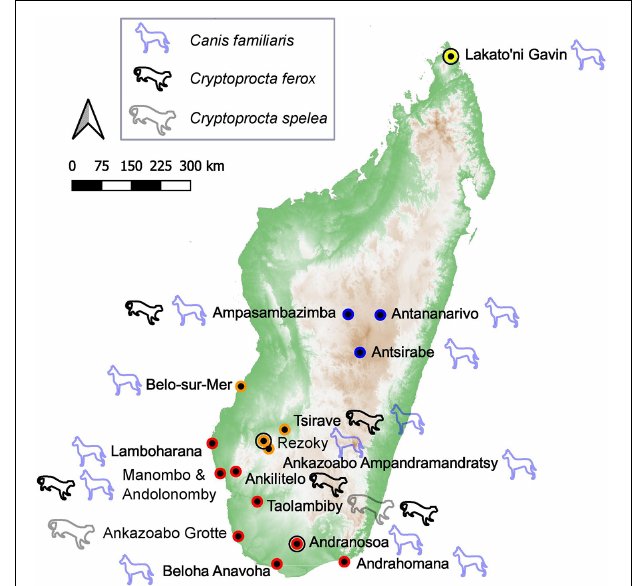
FIGURE 3 | Collection sites of dog and Cryptoprocta spp. bones considered in this study, with archeological sites (Lakoto’ni Gavin, Rezoky, and Andranosa) circled and sites colored according to ecoregion (red = spiny thicket, orange = succulent woodland, blue = central highlands, yellow = dry deciduous